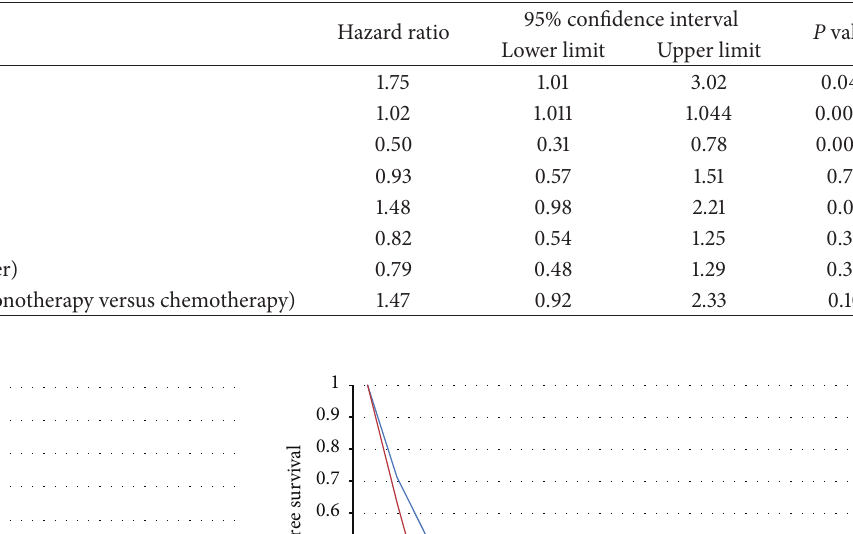
Table 2: Multivariate Cox regression analysis of parameters possibly related to overall survival of metastatic breast cancer patients.